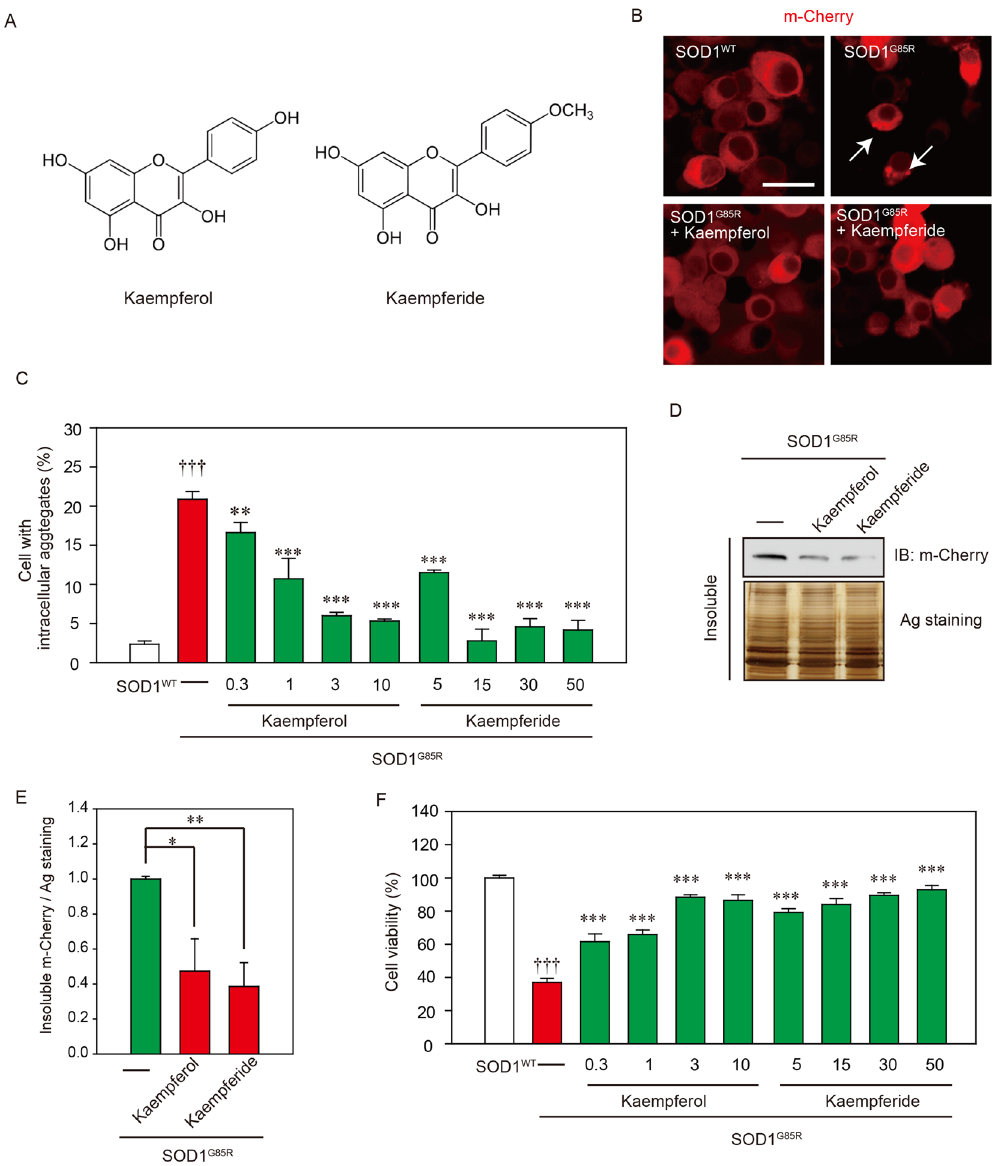
Figure 3. Kaempferol and kaempferide prevented SOD1 G85R -related neurotoxicity. ( A ) Chemical structures of kaempferol and kaempferide. ( B ) Representative fluorescent microscopy images of N2a cells expressing mCherry-SOD1 G85R incubated for 24 h with 3 µ M kaempferol or 15 µ M kaempferide. ( C ) Quantified data of intracellular SOD1 aggregates in N2a cells expressing mCherry-SOD1 G85R incubated for 24 h with kaempferol (from 0.3 µ M to 10 µ M) or kaempferide (from 5 µ M to 50 µ M) are expressed as mean ± S.E.M from three independent experiments. In each experiment, at least 200 cells were counted. ( D ) Reduction of Triton- insoluble mutant SOD1 G85R by kaempferol and kaempferide. After treatment of 3 µ M kaempferol or 15 µ M kaempferide, Triton-insoluble fraction of N2a cells expressing SOD1 G85R was resuspended with 2% SDS and analyzed with immunoblotting. ( E ) The band density of Triton-insoluble mutant SOD1 G85R group is given as mean ± S.E.M from three independent experiments, based on the band density of Triton-insoluble non- treated mutant SOD1 G85R group. ( F ) N2a cells expressing mCherry-SOD1 G85R were treated with kaempferol (from 0.3 µ M to 10 µ M) or kaempferide (from 5 µ M to 50 µ M). The cell viability was measured by MTT assay. Data is expressed as mean ± S.E.M from three independent experiments, based on SOD1 WT group. * p < 0.05; ** p < 0.01; *** p < 0.001. Scale bar: 20 µ